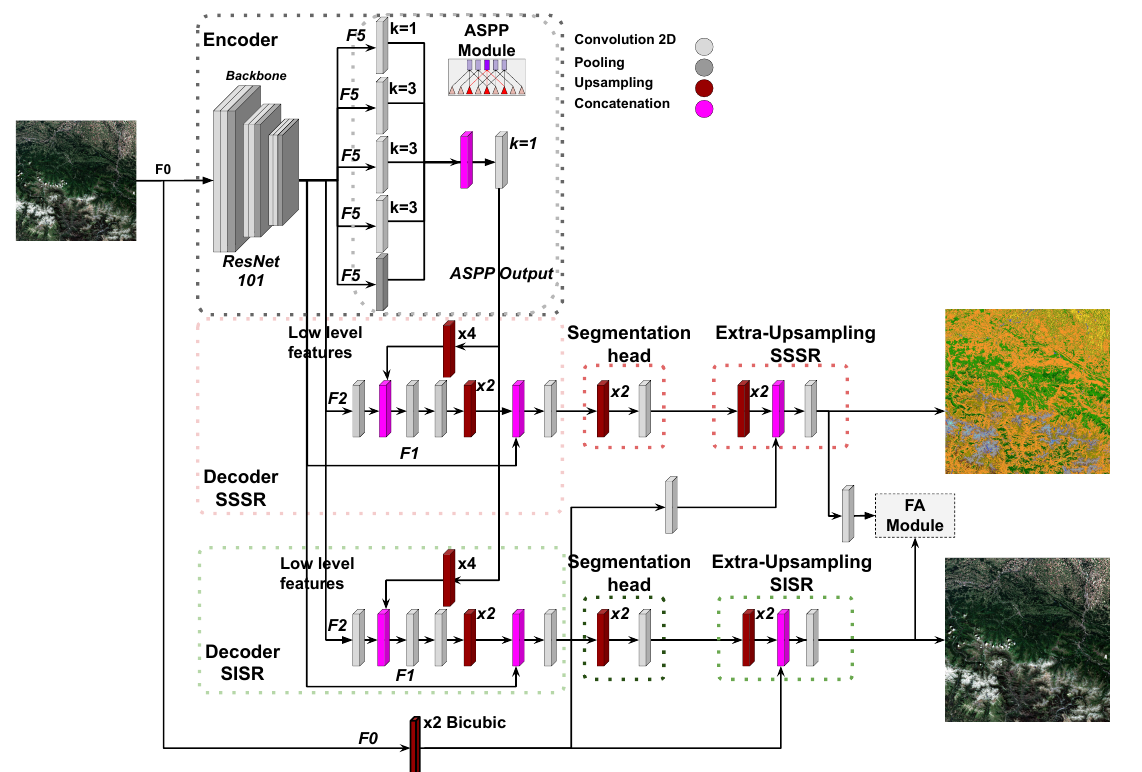
Figure 5. Dual Path Network based on DeepLabv3+. Model v